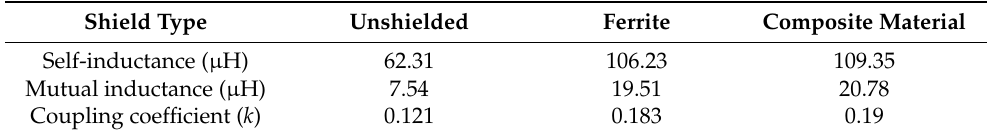
Table 2. Coil inductance simulation results.